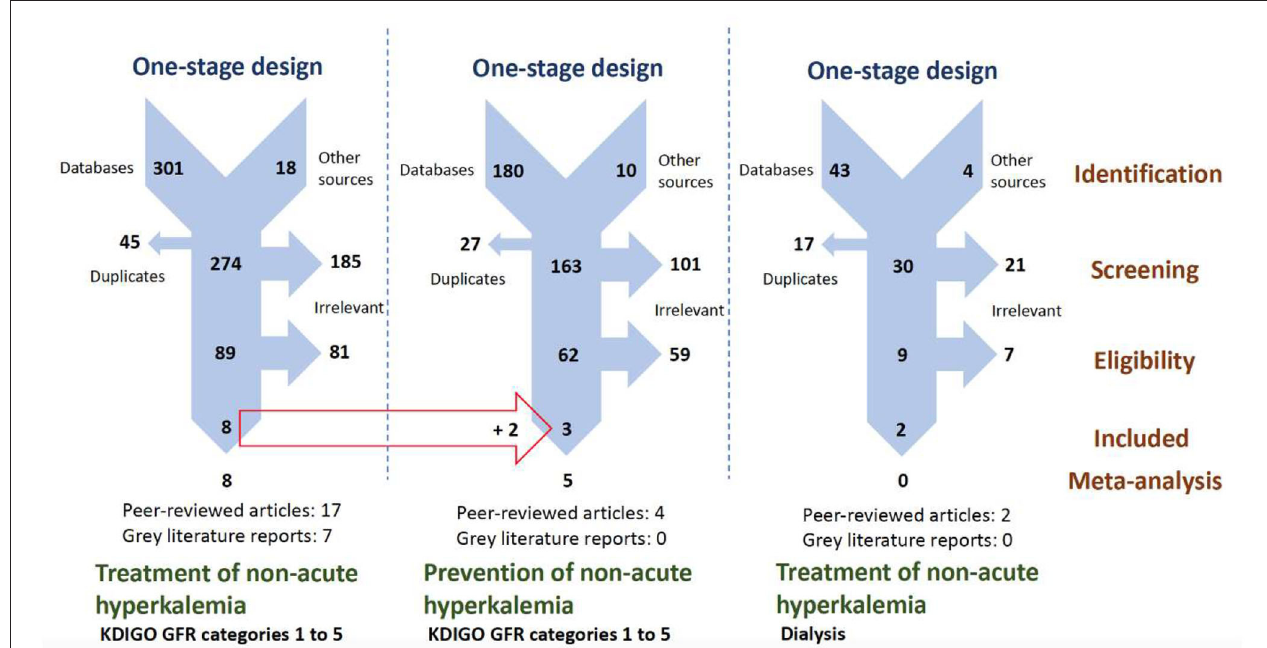
FIGURE 1 | PRISMA flowcharts presenting our parallel one-stage systematic review selection process for retrieving CT providing mathematical data on treatment and prevention of hyperkalemia using potassium-binding polymers. CT, clinical trial; GFR, glomerular filtration rate; KDIGO, kidney disease–improving global outcomes; PRISMA, preferred reporting items for systematic reviews and